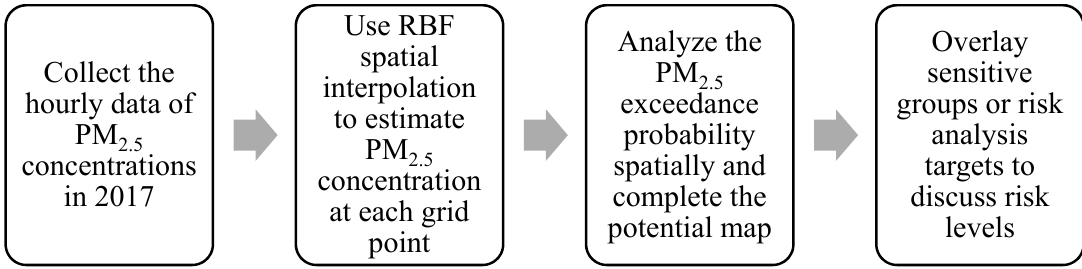
Figure 2. Flow chart of the construction of an air pollution potential map and risk analysis.